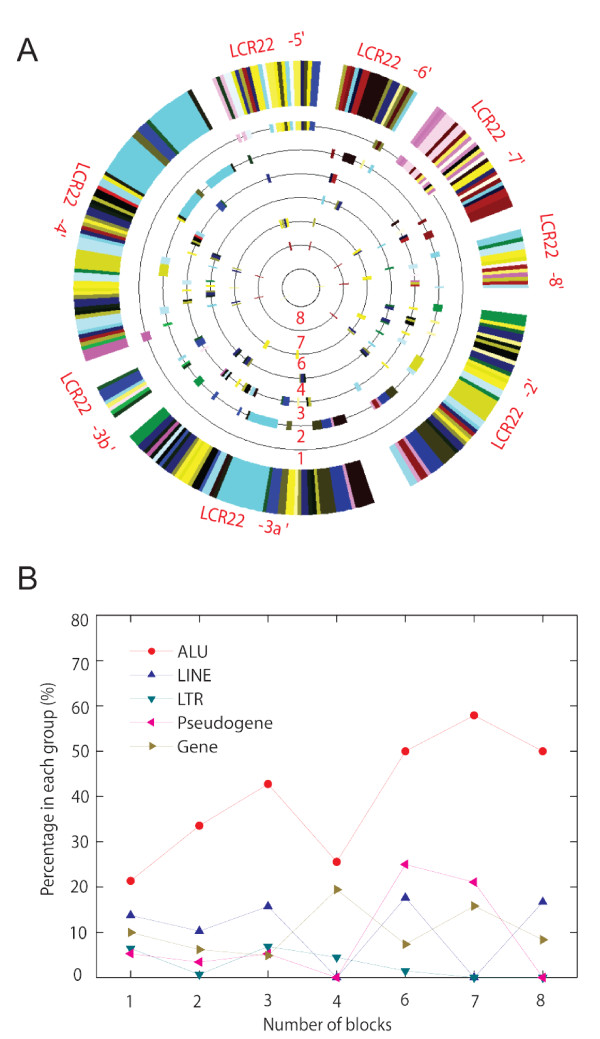
Subunit family spreading in multiple LCR22' blocks is often adjacent to Alu repeats. (A) The SD subunits were assigned to different layers of circles, whereas the numbers represent the total blocks in which a subunit family has one or more members. For example, a subunit family is given 3 if its members are found in 3 of the 8 blocks, and consequently all subunits of this family will be drawn in the circle labeled with "3". (B) Relationship between selected sequence features and block occupancy for SD subunits. The x-axis describes the number of blocks a subunit family occupies (A). The y-axis shows the percentage of subunit endpoints with a given sequence feature. No subunit family was found in and only in five blocks.